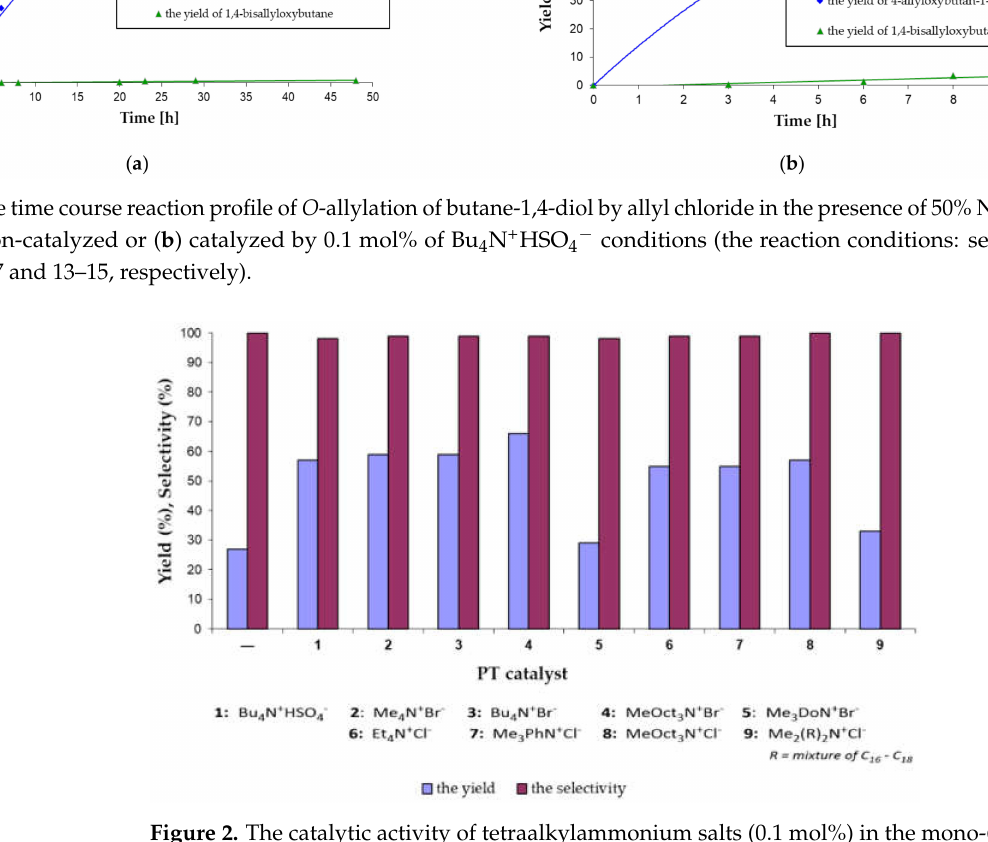
Figure 2. The catalytic activity of tetraalkylammonium salts (0.1 mol%) in the mono- O -allylation of butane-1,4-diol by allyl chloride toward 4-allyloxybutan-1-ol in the presence of 50% NaOH(aq) (the reaction conditions: see Table 1, entry